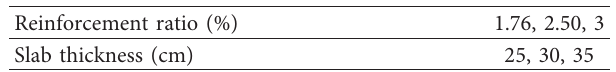
Table 11: Selected calculation